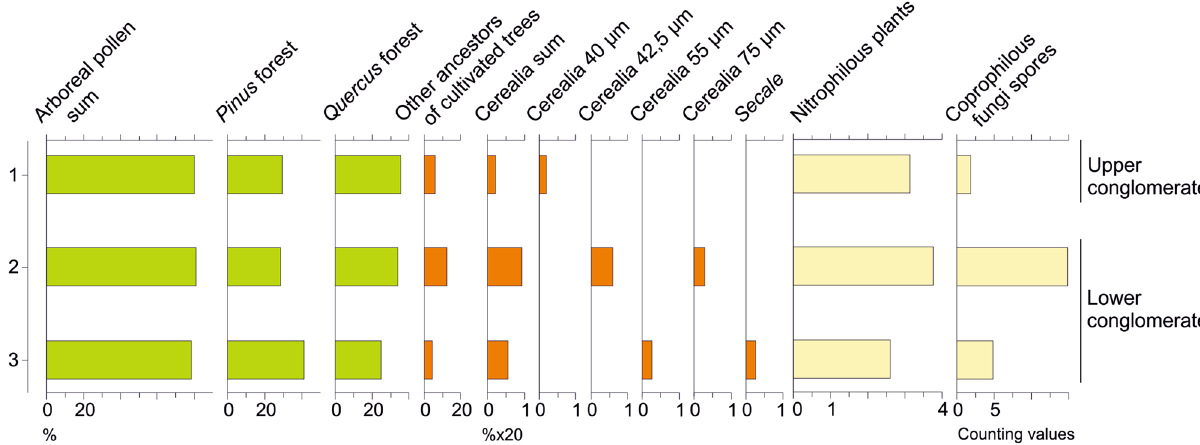
Figure 8. Simplified pollen and NPP diagram in percentages of Kocabaş (Faber quarry, 37°51’N, 29°21’E., 580 m alt.). 3 samples were taken in the fluviatile facies (lower and upper conglomerate) of the travertine formation (details in Lebatard et al.